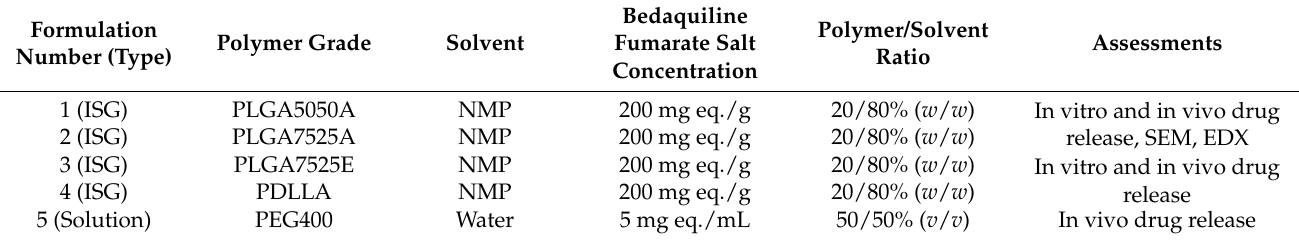
Table 1. Formulations prepared for in vitro and/or in vivo